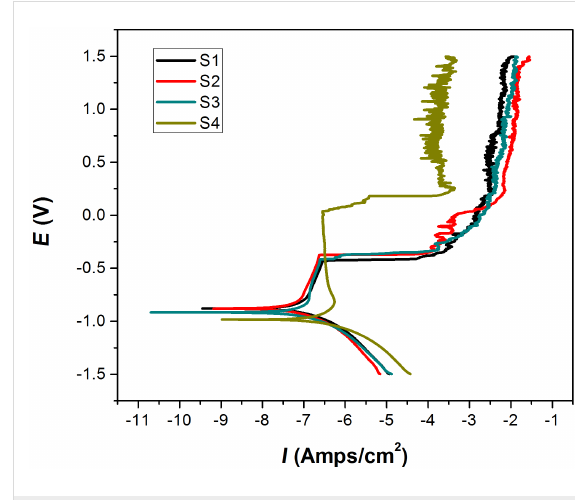
Figure 6: XRD patterns of the various prepared samples. Figure 7: Electric polarization curve for the various prepared